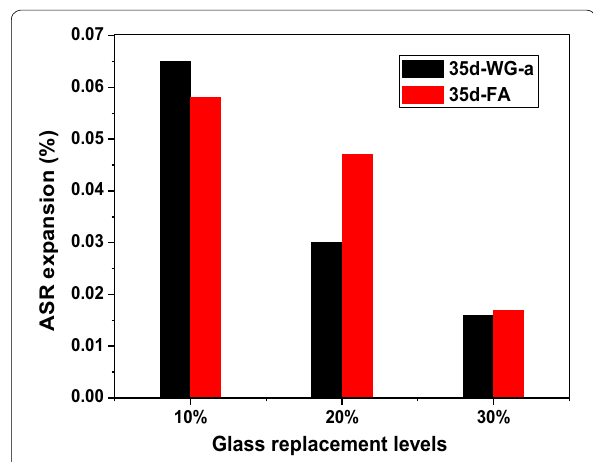
Fig. 6 ASR expansions of cement mortar bars incorporating waste glass powder and fly ash at curing age of 35 days.